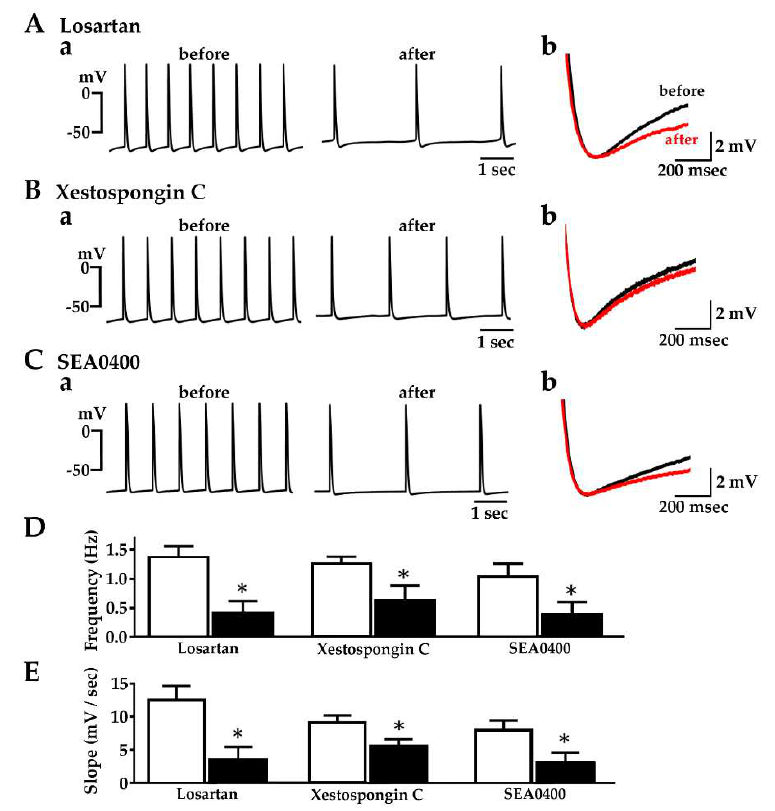
Figure 6. Effect of losartan, xestospongin C and SEA0400 on spontaneous action potentials. ( A ): Typical traces before and after the application of 10 µ M losartan (a) and their diastolic depolarization phase overlaid for comparison (b); ( B ) Typical traces before and after the application of 3 µ M xestospongin C (a) and their diastolic depolarization phase overlaid for comparison (b); ( C ) Typical traces before and after the application of 1 µ M SEA0400 (a) and their diastolic depolarization phase overlaid for comparison (b); ( D ) Summarized results for the decrease in action potential firing frequency; ( E ) Summarized results for the decrease in the diastolic depolarization slope. Open and closed columns in D and E indicate the values before and after the addition of agents, respectively. Columns and vertical bars indicate the mean ± S.E.M. from 6 experiments. Asterisks indicate statistical significance ( p < 0.05) as evaluated by the paired t -test.